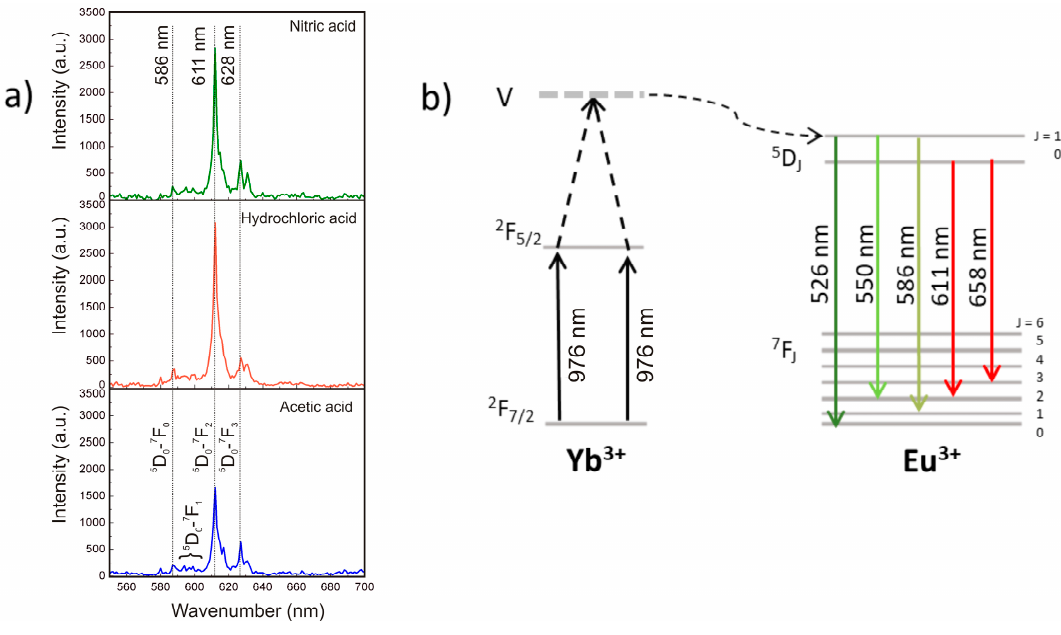
Figure 10. ( a ) Emission spectra of the Yb/Eu doped Y 2 O 3 nanostructures obtained at 976 nm, and ( b ) Energy level diagram for Yb 3+ and Eu 3+ together with the relevant luminescence transitions between the 5 D 0 and the 7 F J states.